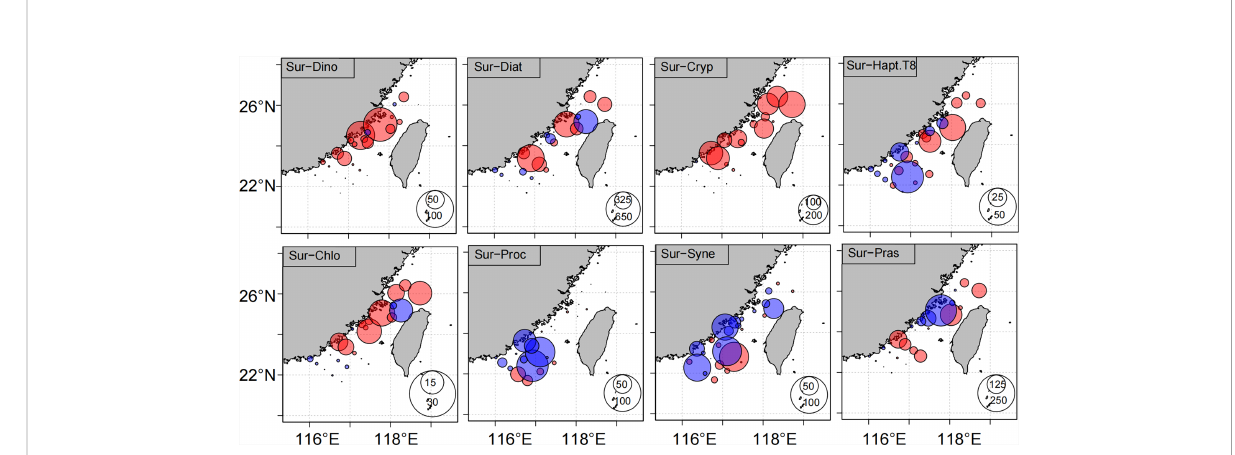
FIGURE 7 The differences in concentrations of dino fl agellates (Dino, ng L − 1 ), diatoms (Diat, ng L − 1 ), cryptophytes (Cryp, ng L − 1 ), haptophytes (Type 8; Hapt.T8, ng L − 1 ), chlorophytes (Chlo, ng L − 1 ), Prochlorococcus (Proc, ng L − 1 ), Synechococcus (Syne, ng L − 1 ) and prasinophytes (Pras, ng L − 1 ) in the surface water between 2016 and 2018. Notes: red and blue circles represent the positive and negative values,